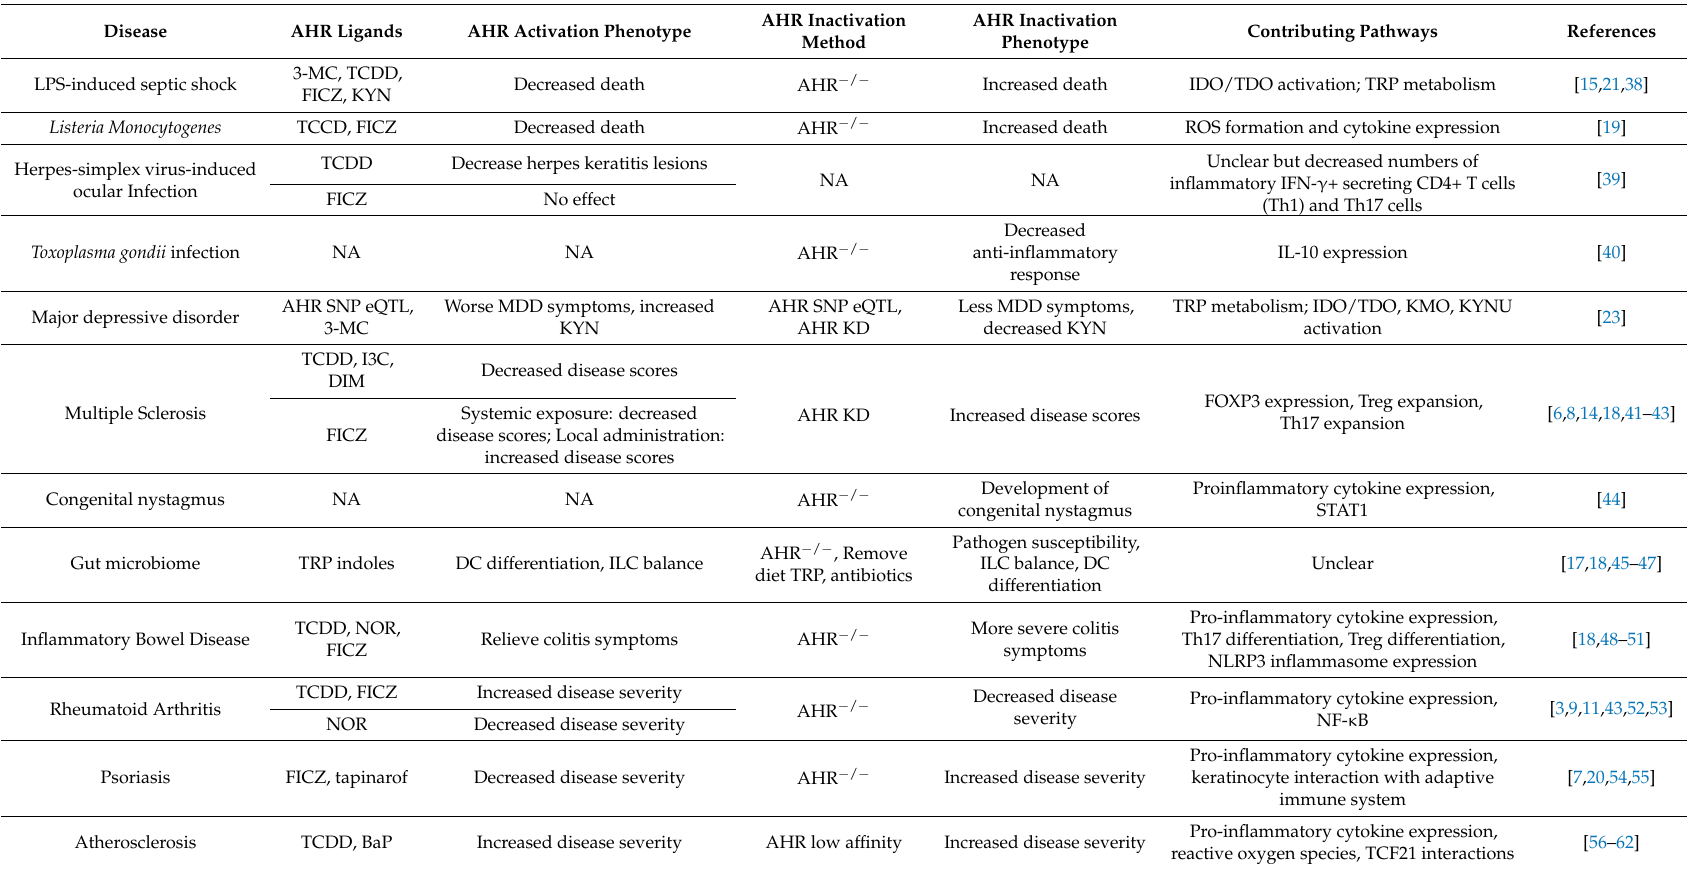
Table 2. Effect of AHR on disease phenotypes and pathways implicated in the